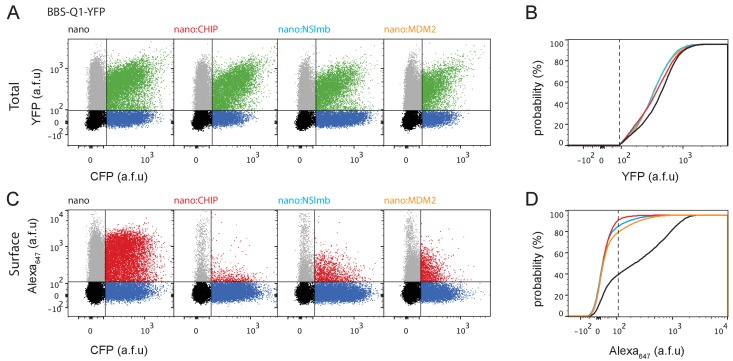
Screening the effects of different engineered E3 ligases.(A) Flow cytometry analyses of total Q1 expression (YFP fluorescence) in cells expressing BBS-Q1-YFP + nanobody (left, control) or BBS-Q1-YFP + nanoCHIP, nanoNSlmb (termed deGradFP), or nanoMDM2. (B) Cumulative distribution histograms of YFP fluorescence for BBS-Q1-YFP co-expressed with either nanobody (black line) or nanoCHIP (red line), nanoNSlmb (blue line), or nanoMDM2 (orange line). (C) Flow cytometry analyses of surface Q1 channels (Alexa647 fluorescence) in cells expressing BBS-Q1-YFP + nanobody (left, control) or BBS-Q1-YFP + nanoCHIP, nanoNSlmb, or nanoMDM2. (D) Cumulative distribution histograms of Alexa647 fluorescence for BBS-Q1-YFP co-expressed with either nanobody (black line) or nanoCHIP (red line), nanoNSlmb (blue line), or nanoMDM2 (orange line).